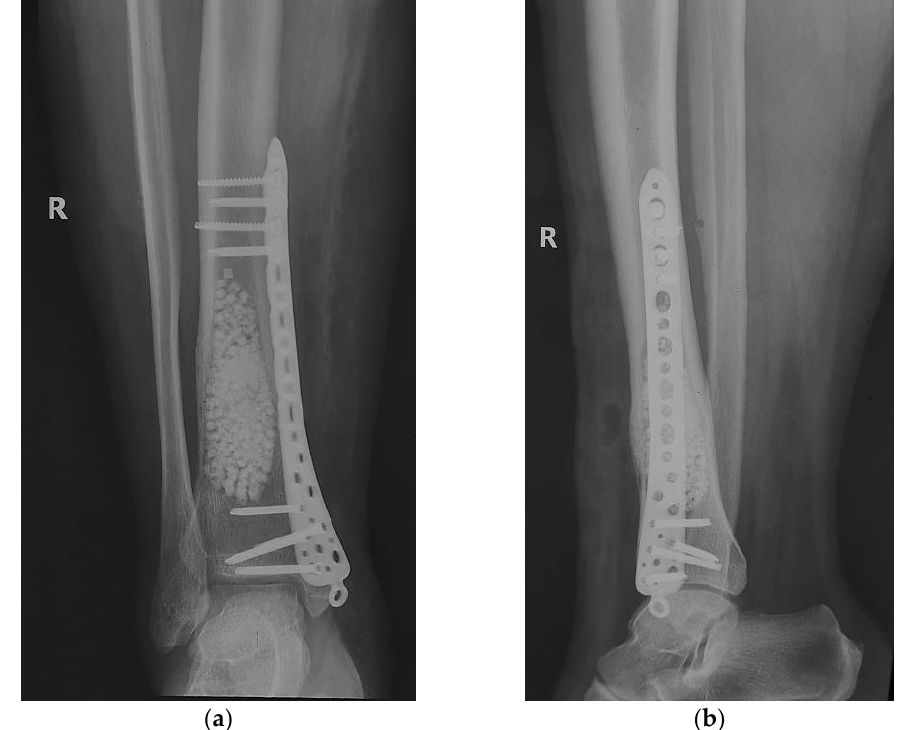
Figure 10. Curettage, bone substitute grafting and plate osteosynthesis. After surgery radiographs ( a ) Radiological, coronal view; ( b ) Radiological, lateral